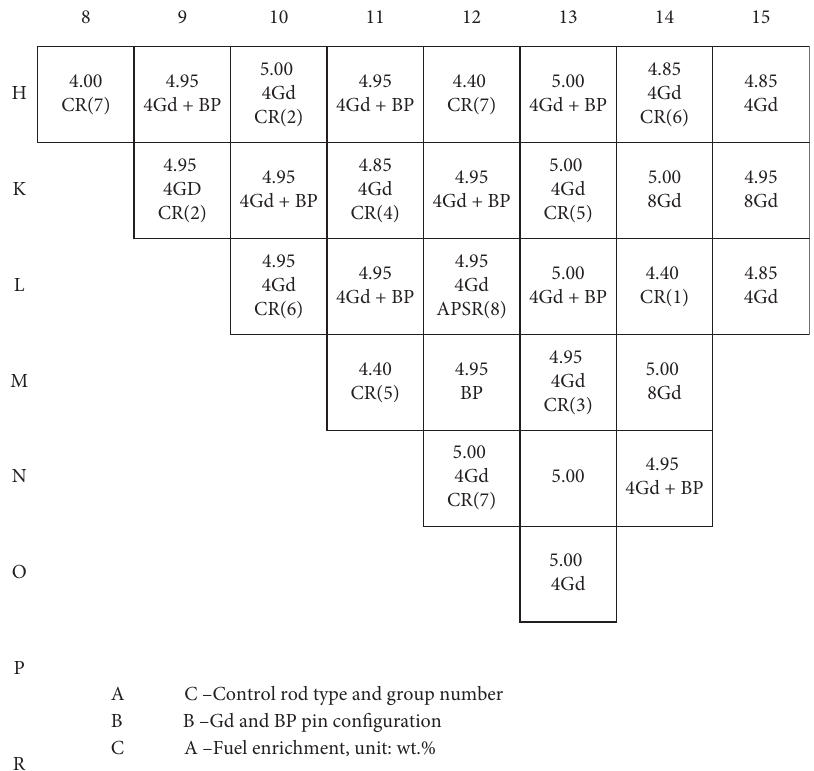
Figure 2: A quarter-core representation of TMI-1